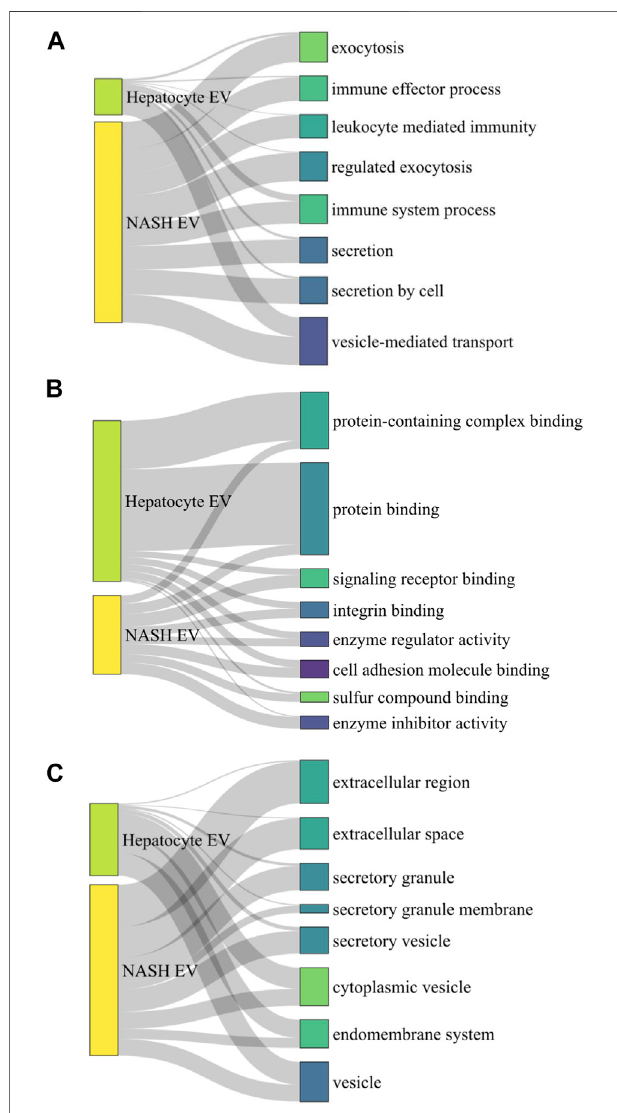
FIGURE 9 | Sankey diagram linking palmitate-stimulated EV proteins with NASH plasma EV proteins. Sankey diagram linking top 8 commonly detectedgeneontology(GO)termsfrom1,766hepatocyte-derivedpalmitate- stimulatedEVproteinsand357humanNASHplasmaEVproteins, (A) by biological process analysis, (B) by molecular function analysis, and (C) by cellular component analysis. A ribbon ’ s thickness indicates − log10FDR for each cluster of GO terms in each GO